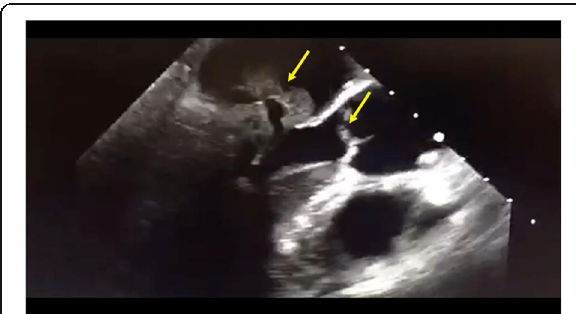
Fig. 2 Transesophageal echocardiography (TEE) demonstrating mitral and aortic valvular